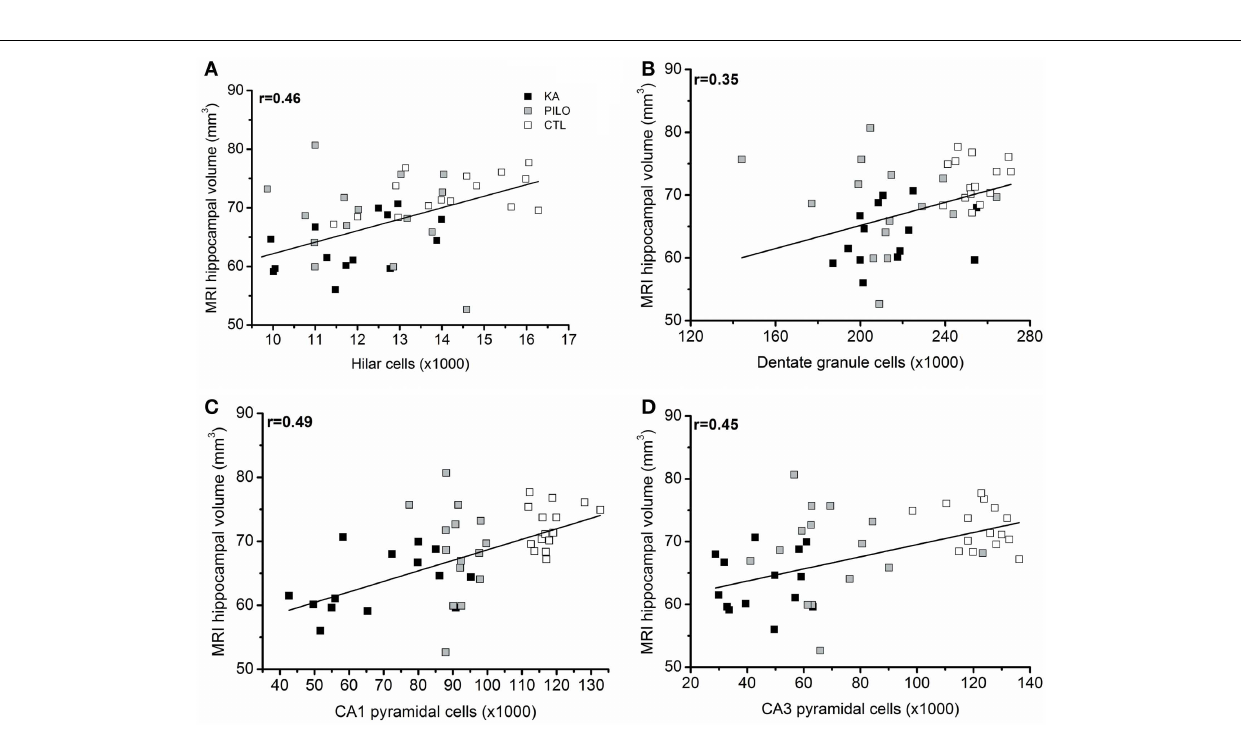
FIGURE 6 | (A) correlation between the number of dentate hippocampal cells and the MRI hippocampal volume was positive for the hilus ( r = 0.46, P = 0.00143), granule cell layer [ (B) , r = 0.35, P = 0.02007]. Correlation was also positive for pyramidal CA1 (C) ( r = 0.49, P = 0.00071) and CA3 cells (D) ( r = 0.45, P =